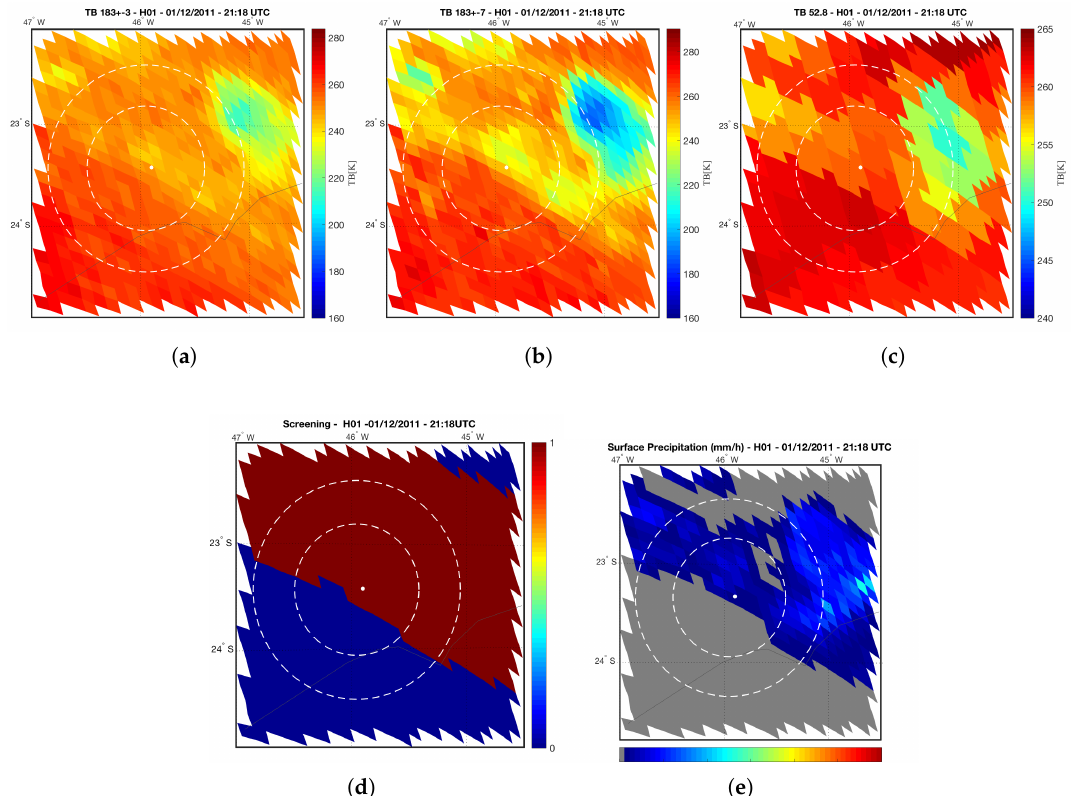
Figure 21. ( a ) TB 183 ± 3 GHz, ( b ) TB 183 ± 7 GHz, ( c ) TB 53 GHz, ( d ) Screening of precipitation (0—no rain, 1—rain) and ( e ) Surface Precipitation (mm/h) on 1 December 2011 at 21:18 UTC in the Vale do Paraíba